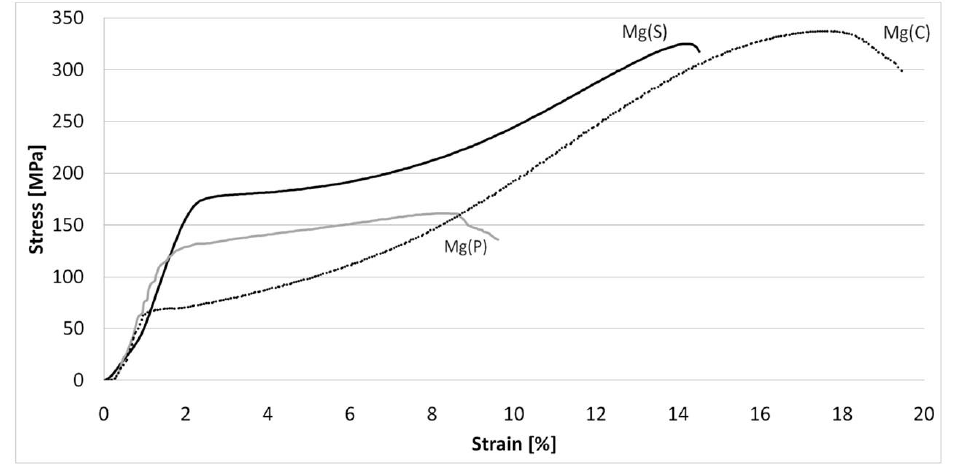
Figure 10. Representative curves obtained in compressive strength tests for magnesium rods extruded by the KOBO method from cold compacted magnesium powder — Mg(P), sintered magnesium powder — Mg(S), and cast magnesium Mg(C).